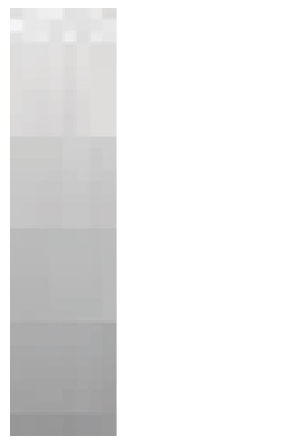
Figure 10: Sample for the cropping range height from ruler